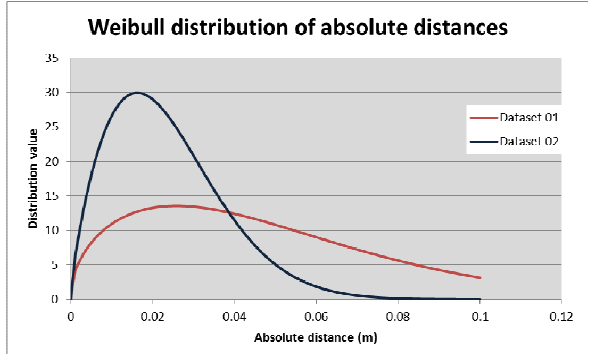
Figure 22: Weibull distribution of absolute distances between the photogrammetric point clouds and the TLS one. Project made using fisheye release in Photoscan.